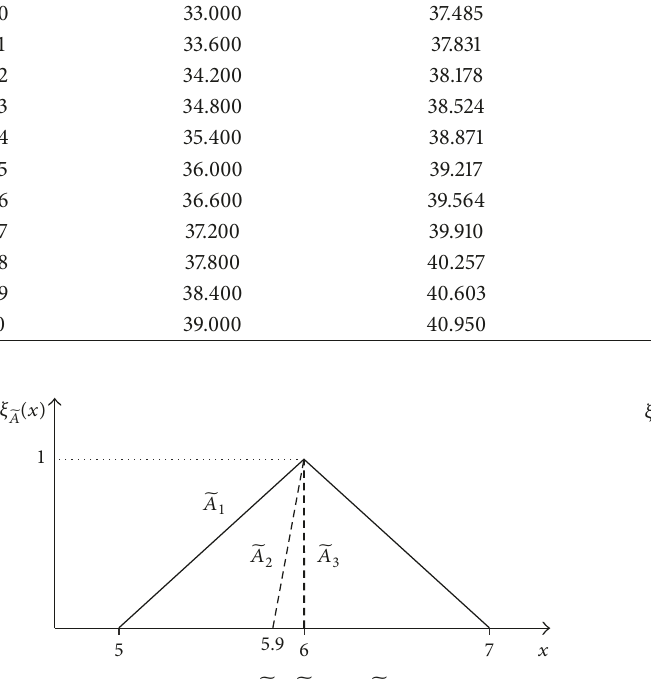
Figure 4: Fuzzy numbers